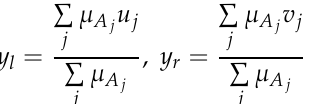
Figure 2. Pioneer 3-DX robot.